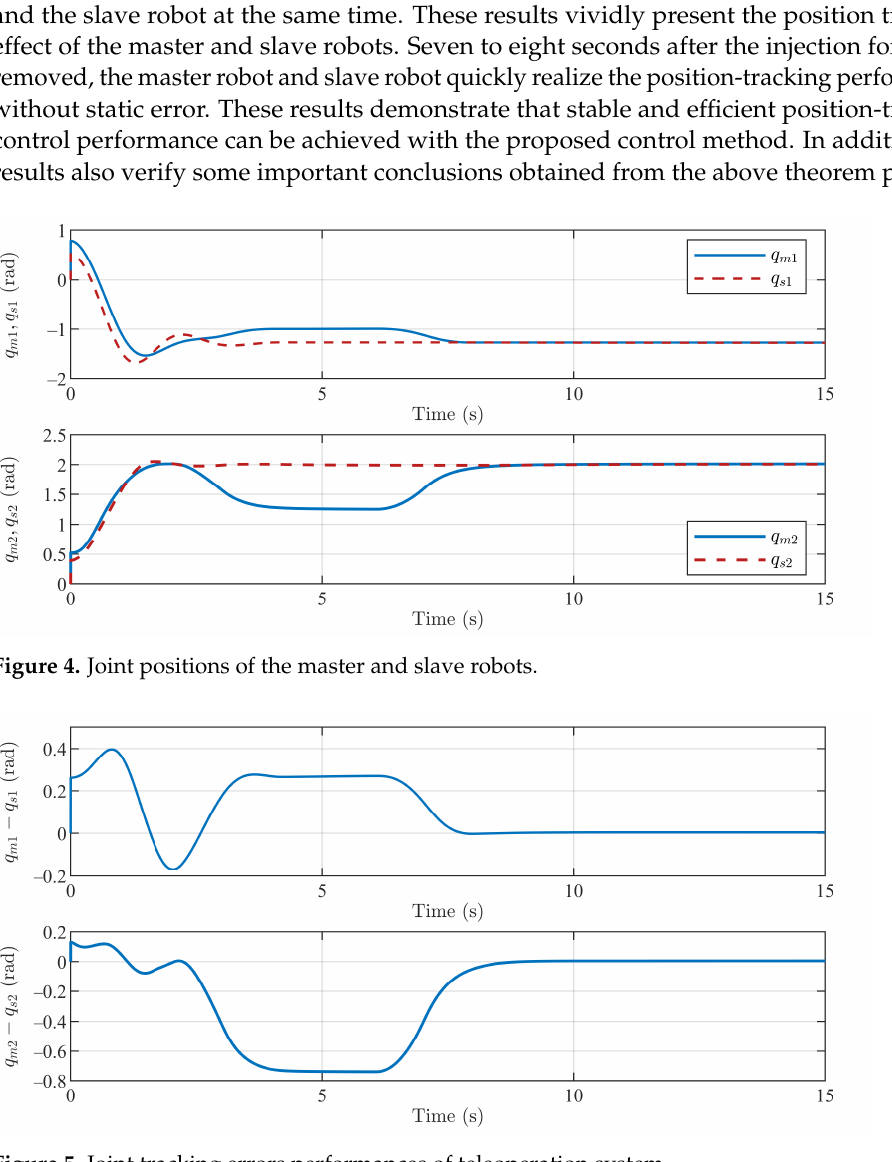
Figure 5. Joint tracking errors performances of teleoperation